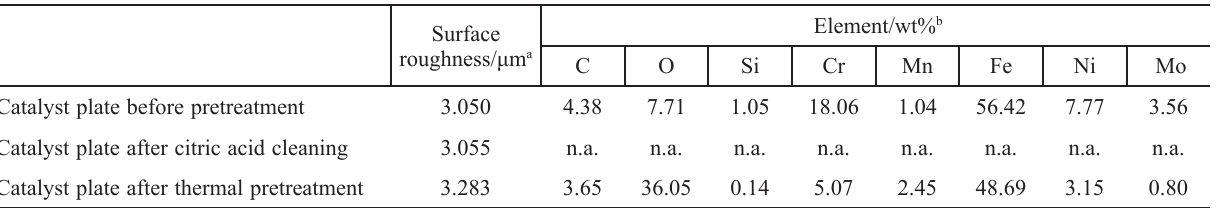
Table 1 – Surface roughness and elemental composition (wt%) of catalyst plate before and after pretreatment